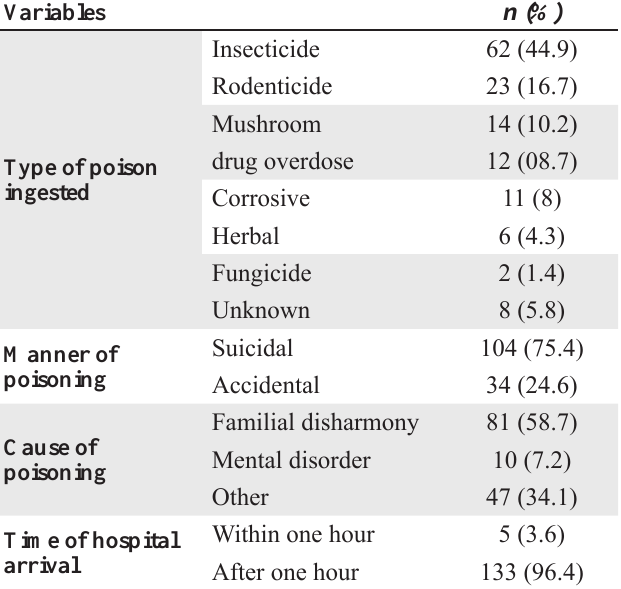
Table 2 : Circumstances of patient with poisoning (N =